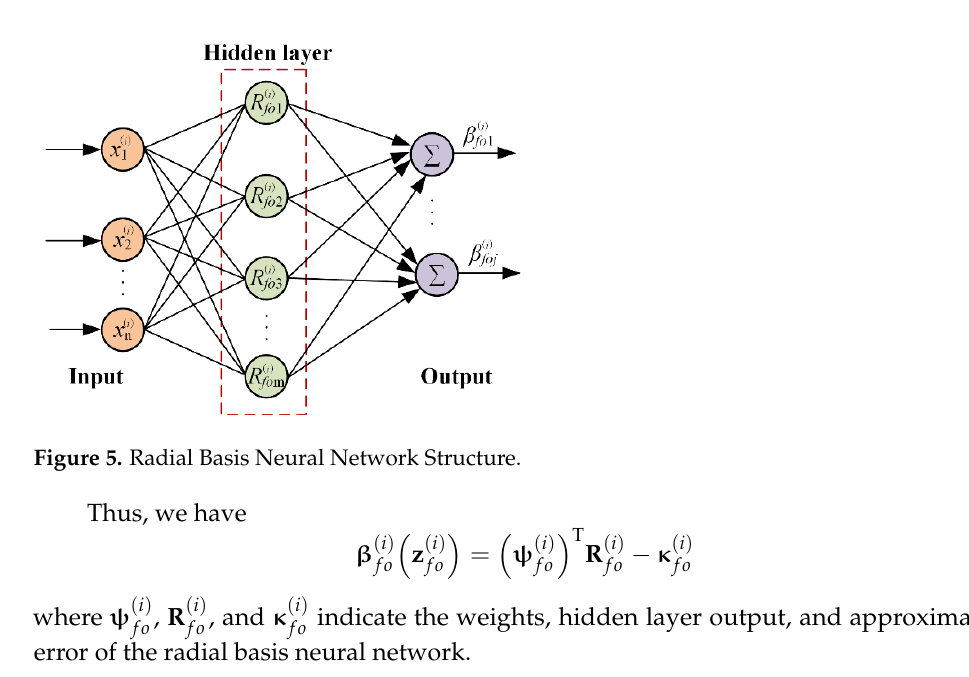
indicate the weights, hidden layer output, and approximation error of the radial basis neural network.